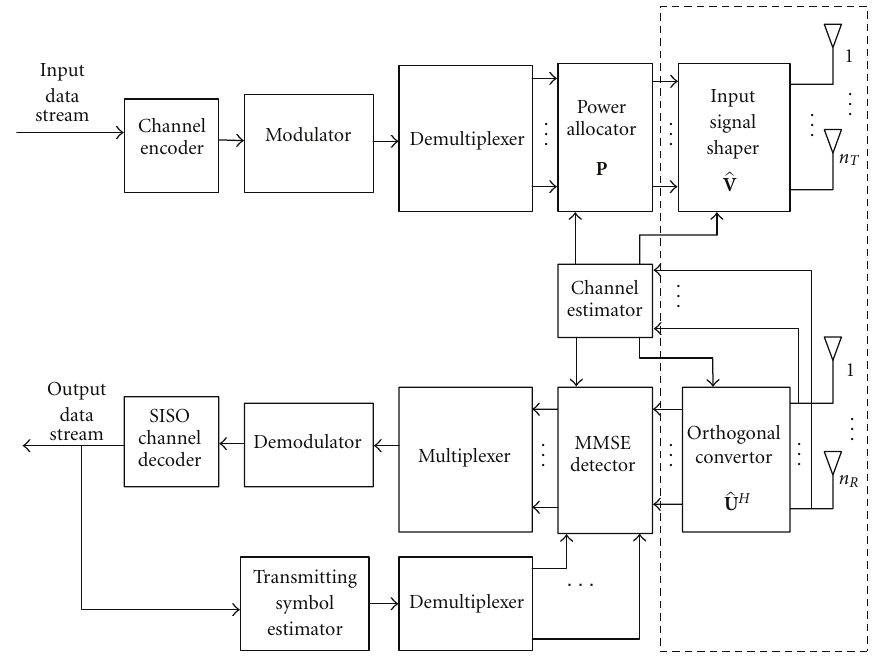
Figure 1: An illustrative diagram of the modified Turbo-BLAST